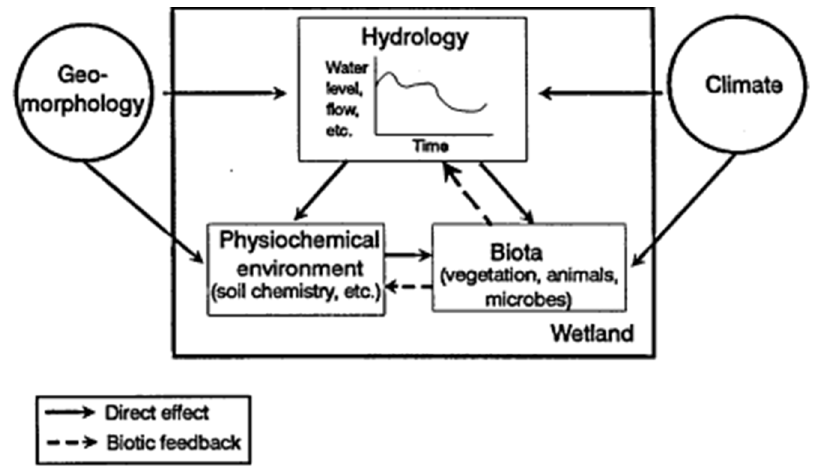
Figure 1. Key characteristics of all wetlands (hydrology, physico-chemical environment and biota), key wetland drivers (geomorphology and climate) and the relationships between them as adapted from National Research Council by Victorian Department of Sustainability and Environment [8].